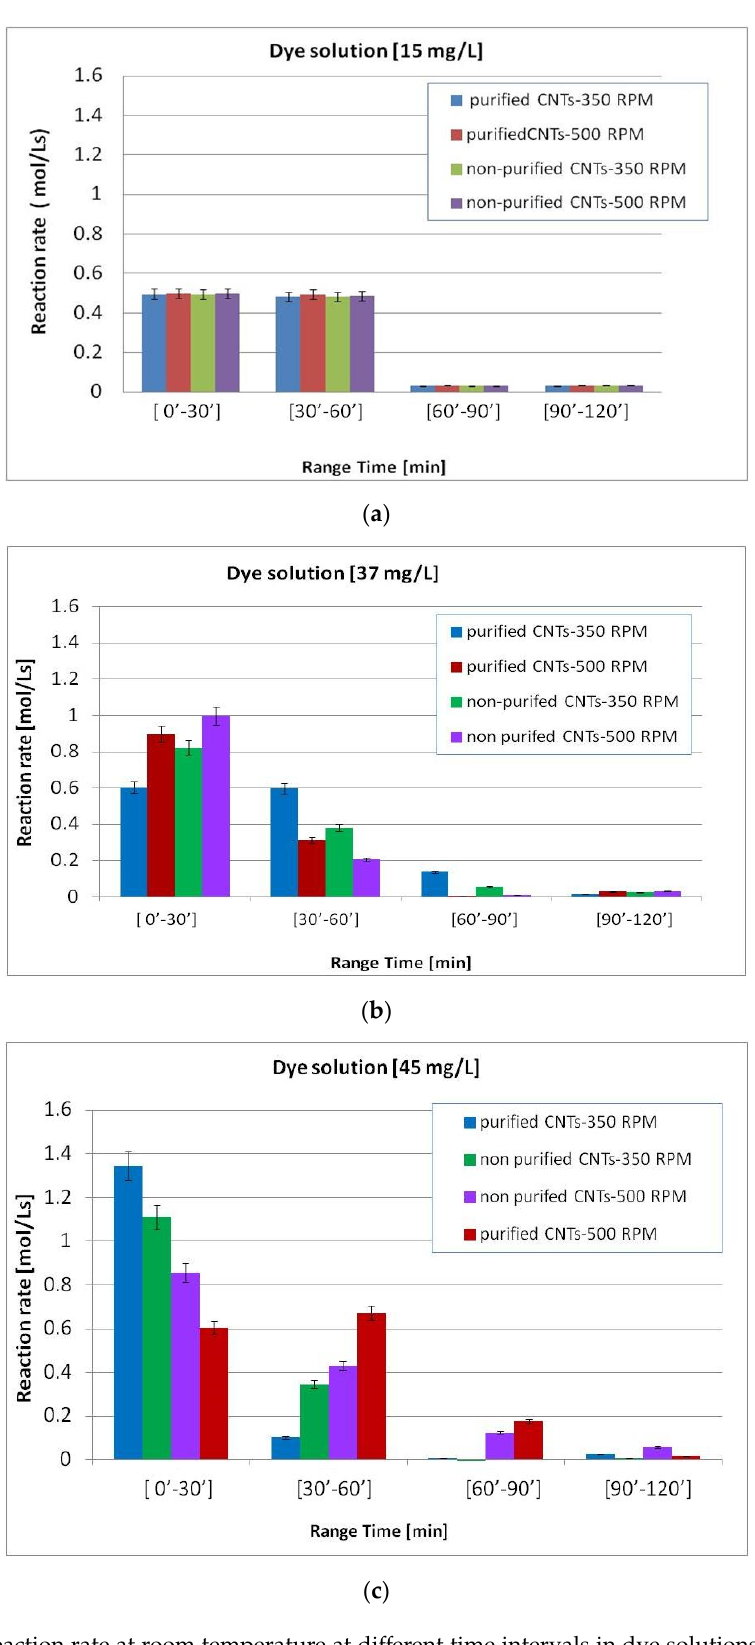
Figure 9. Reaction rate at room temperature at different time intervals in dye solutions with initial concentrations: ( a ) 15 mg/L; ( b ) 37 mg/L; ( c ) 45 mg/L.